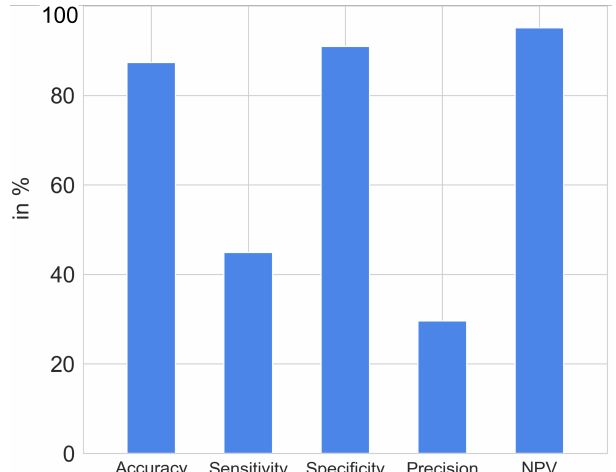
Figure 5. Performance measures: Accuracy, Sensitivity, Specificity, Precision, Negative Predicted